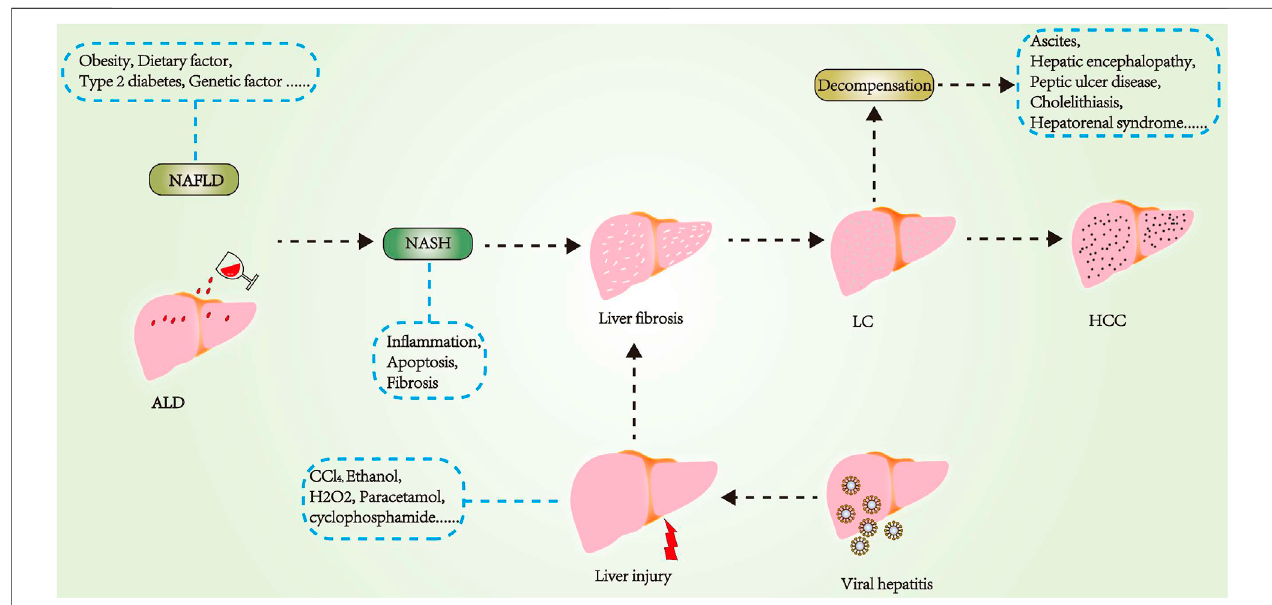
FIGURE 1 | Main pathogenesis of important liver